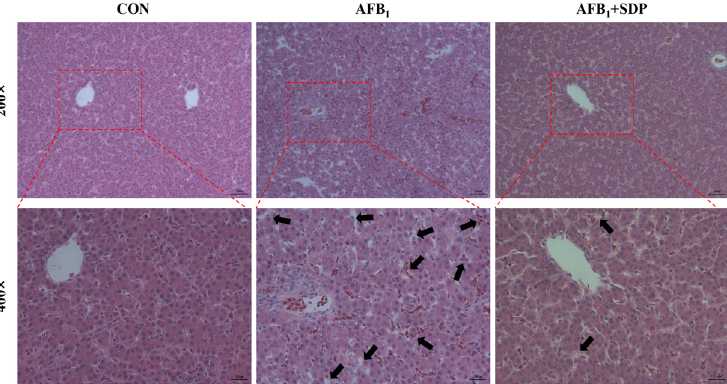
Figure 1. The protective effects of dietary seaweed ( Enteromorpha prolifera )-derived polysaccharides on histopathological changes in liver in broiler chickens. Scale bars for 200× are 50 μ m and 400× are 25 μ m. Arrows indicate the vacuolization, inflammatory cell infiltration and hepatocyte necrosis.